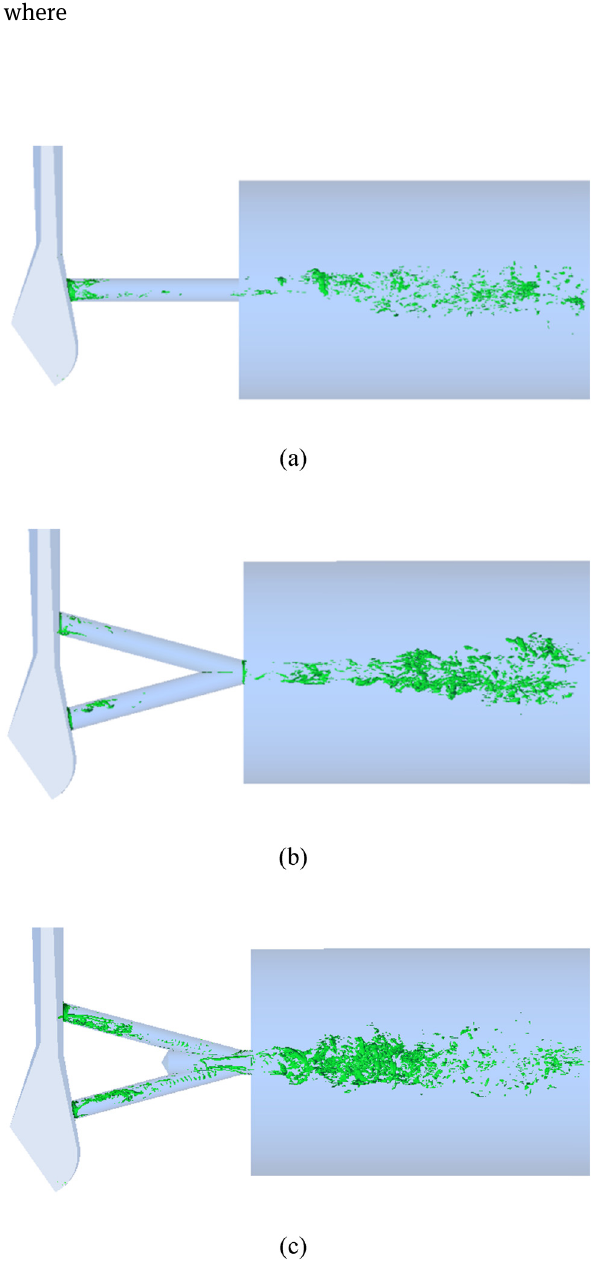
Figure 16: Comparison of the isosurface of Q in di ff erent nozzles. The isosurface of Q in the ( a ) 0A nozzle, ( b ) 30V nozzle, and ( c ) 30Y